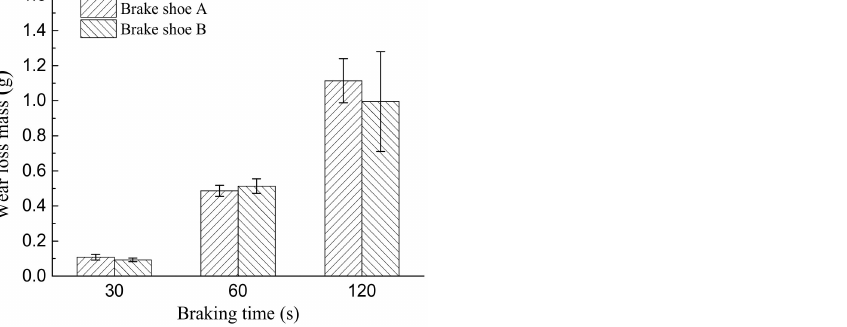
Figure 21. Wear loss masses of brake shoe specimens in cases of different emergency braking